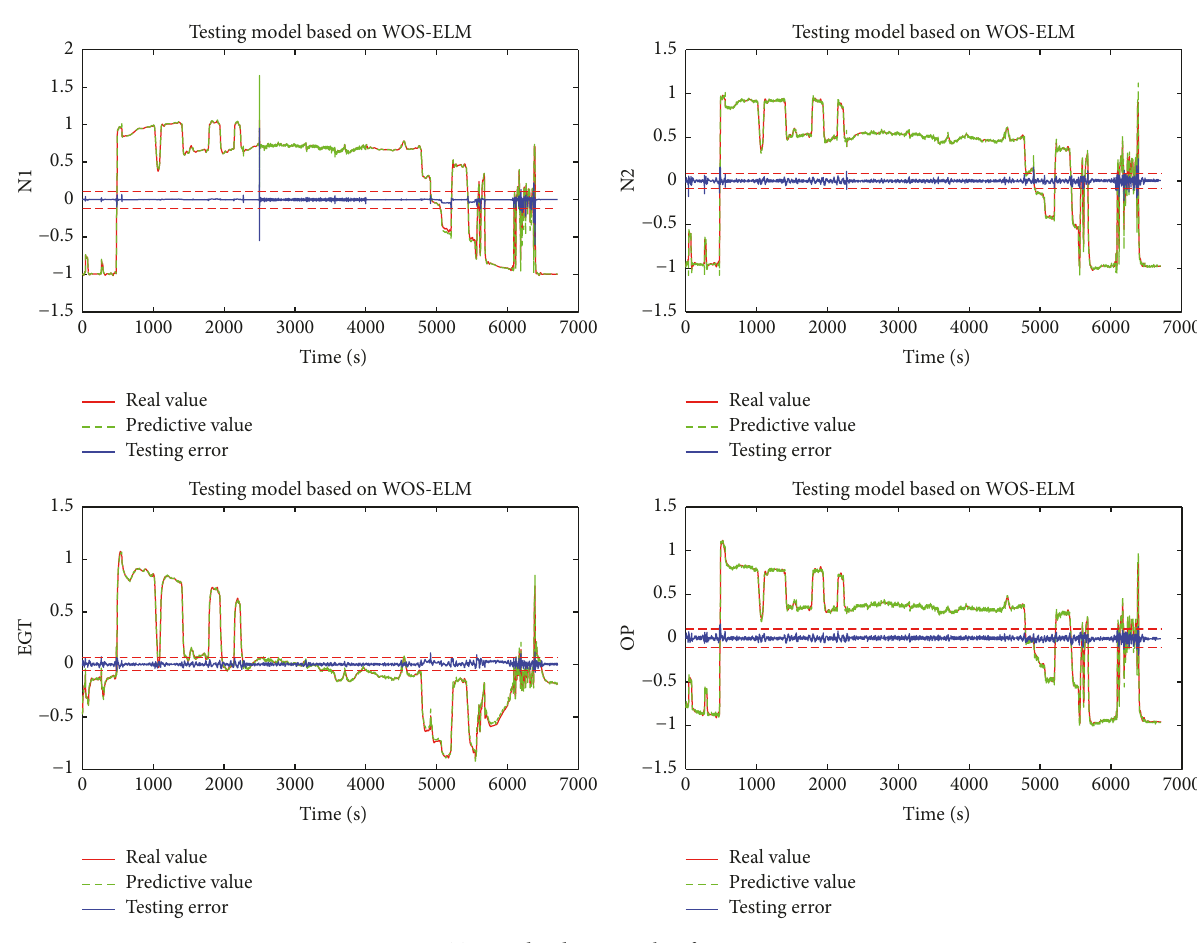
Figure 9: Time redundancy results after